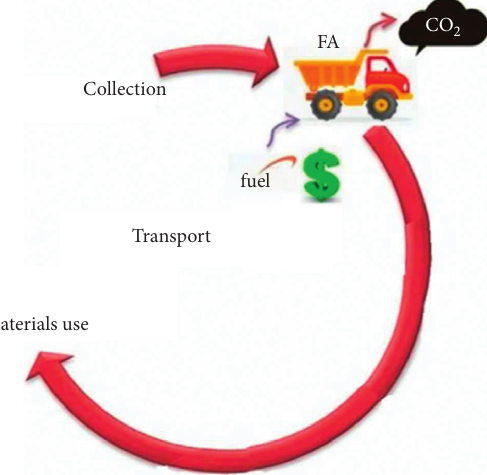
Figure 13: Various stages of the life cycle of fly ash, reproduced from [108], with permission from Elsevier,